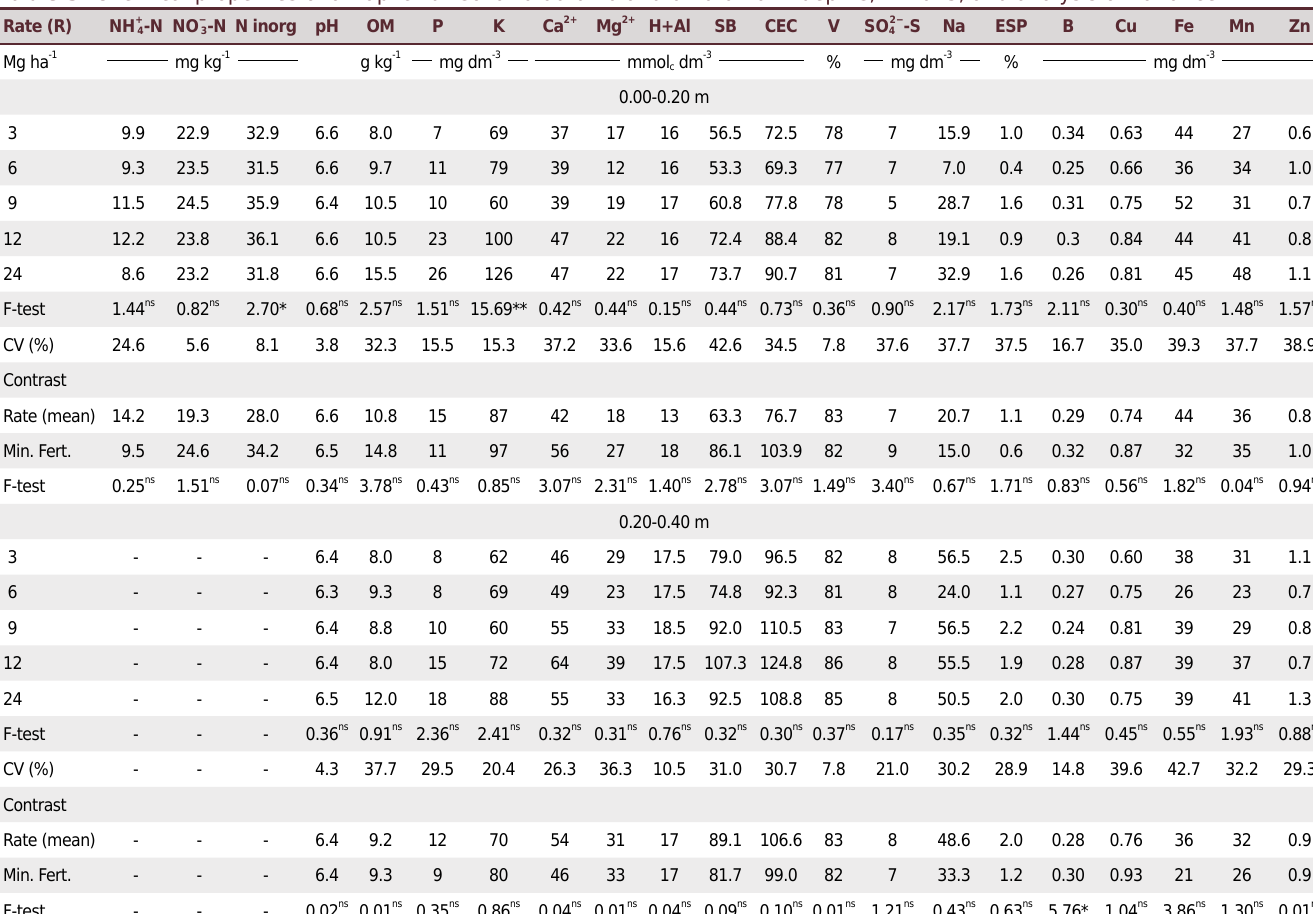
Table 3. Chemical properties of a Haplic Luvisol at 0.00-0.20 and 0.20-0.40 m depths, in 2013, and analysis of